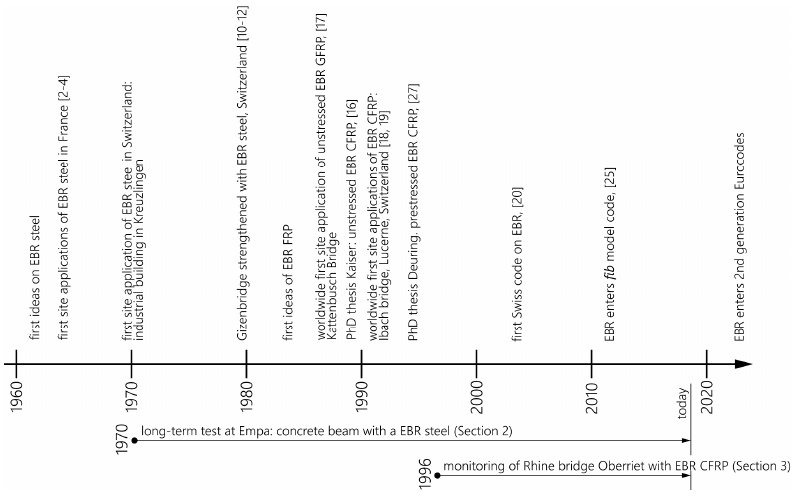
Figure 2. Timeline of the developments of the strengthening of reinforced concrete (RC) by externally bonded reinforcement (EBR).